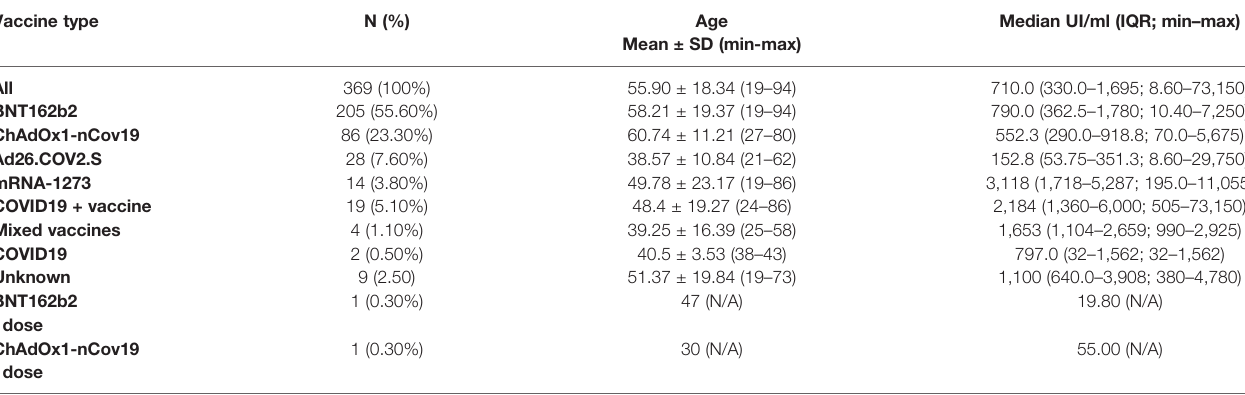
TABLE 1 | Median anti-RBD antibody titers and demographic details of tested population. Vaccine